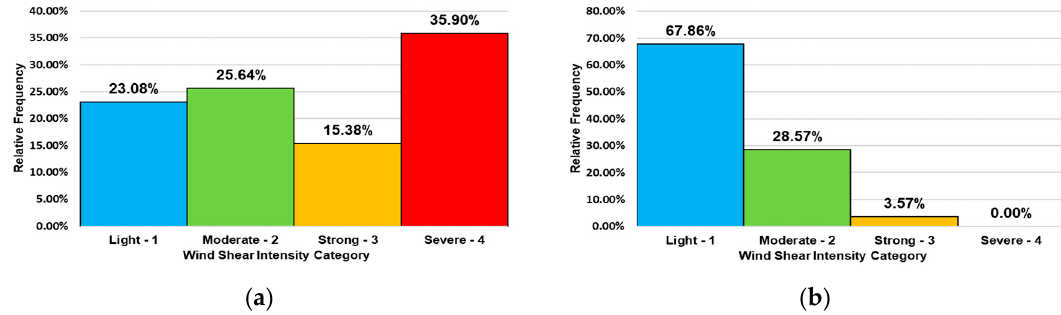
Figure 5. Relative frequency per wind shear intensity category for: ( a ) Flight 1; and ( b ) Flight 2.